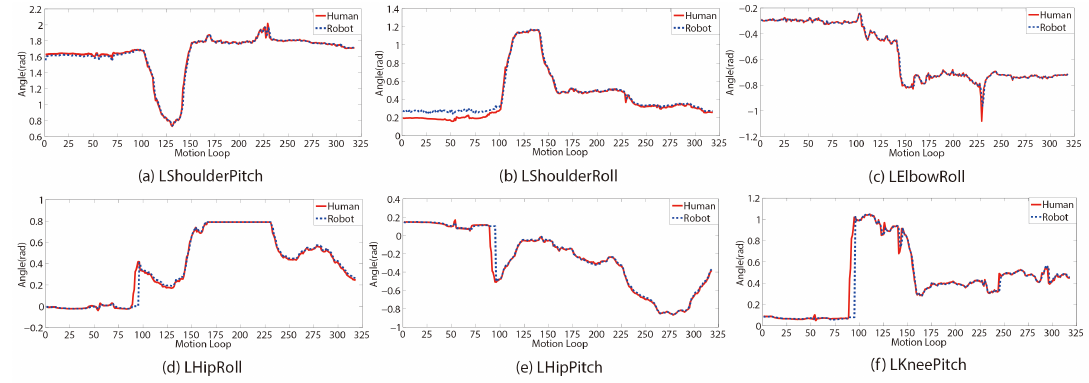
Figure 11. Left key joint angle trajectories of the human and the robot in the first experiment. ( a )–( f ) depict the joint angle trajectories of LShoulderPitch, LShoulderRoll, LElbowRoll, LHipRoll, LHipPitch and LKneePitch, respectively.